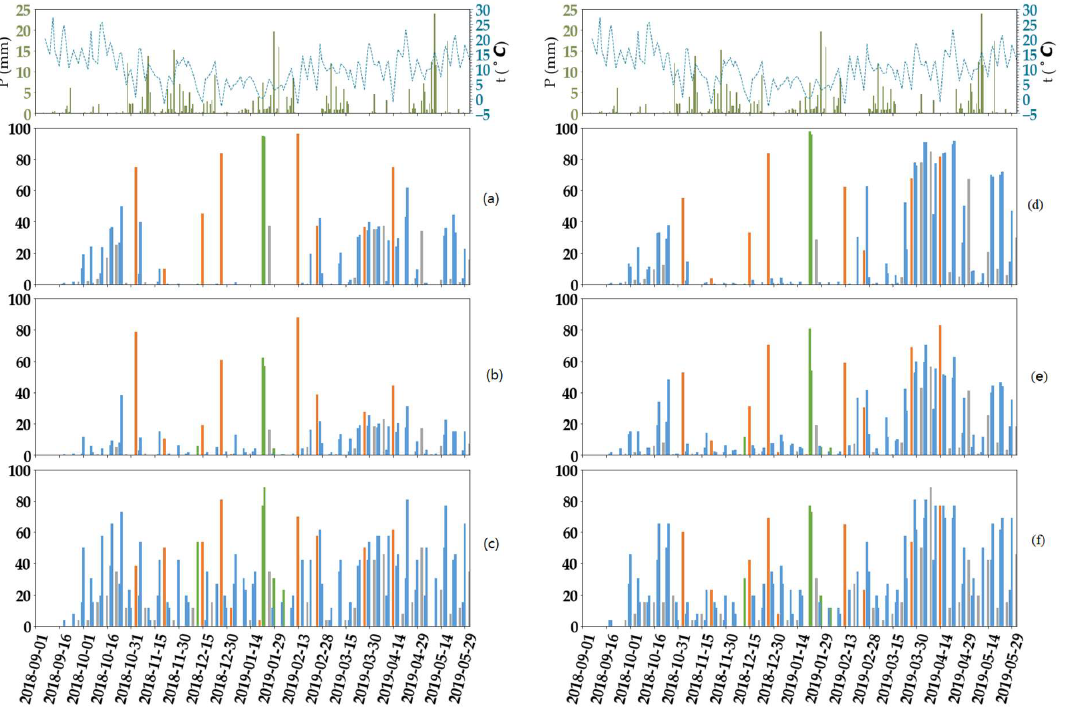
Figure 8. Percentage of plots detected as frozen in site A for each S1 acquisition date, using VH and VV polarizations.), ( a ) VH-LC1, ( b ) VH-LC2, ( c ) VH-LC3, ( d ) VV-LC1, ( e ) VV-LC2, ( f ) VV-LC3. Precipitation (P) and temperature (t) are given in the graph at the top.